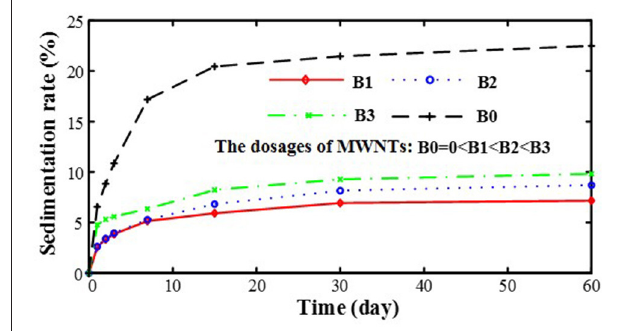
FIGURE 8 | Sedimentation rate of MR fluids with the different dosages of